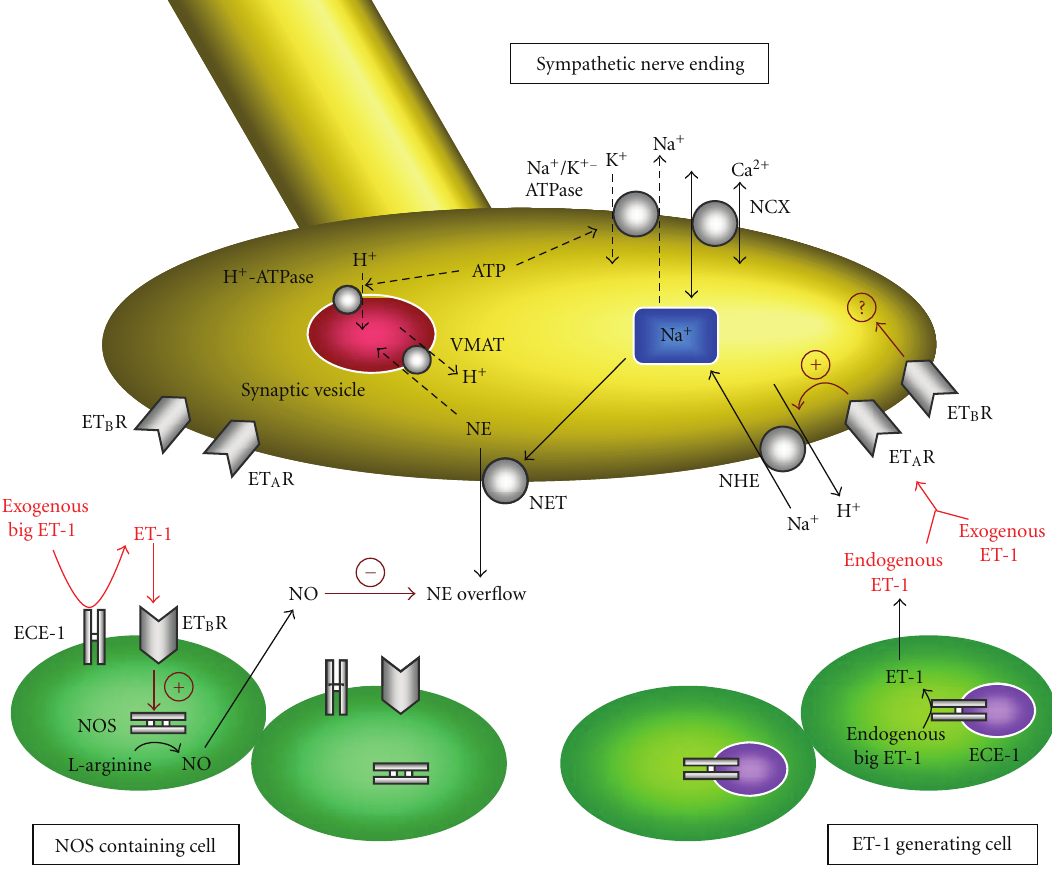
Figure 1: Summarizing scheme illustrating the interaction between the ET-1 system and carrier-mediated NE release in protracted myo- cardial ischemia. Stimulation of ET A Rs existing in sympathetic nerve endings by endogenously generated or exogenously applied ET-1 increases neuronal NHE activity, thus potentiating carrier-mediated NE release. In contrast, exogenously applied big ET-1 is converted to ET- 1 by cell surface ECE-1, and this ET-1 preferentially binds to ET B Rs located on NOS containing cells to produce NO. Endogenously generated NO works to prevent carrier-mediated NE release. NCX, Na + /Ca 2+ exchanger; VMAT: vesicular monoamine